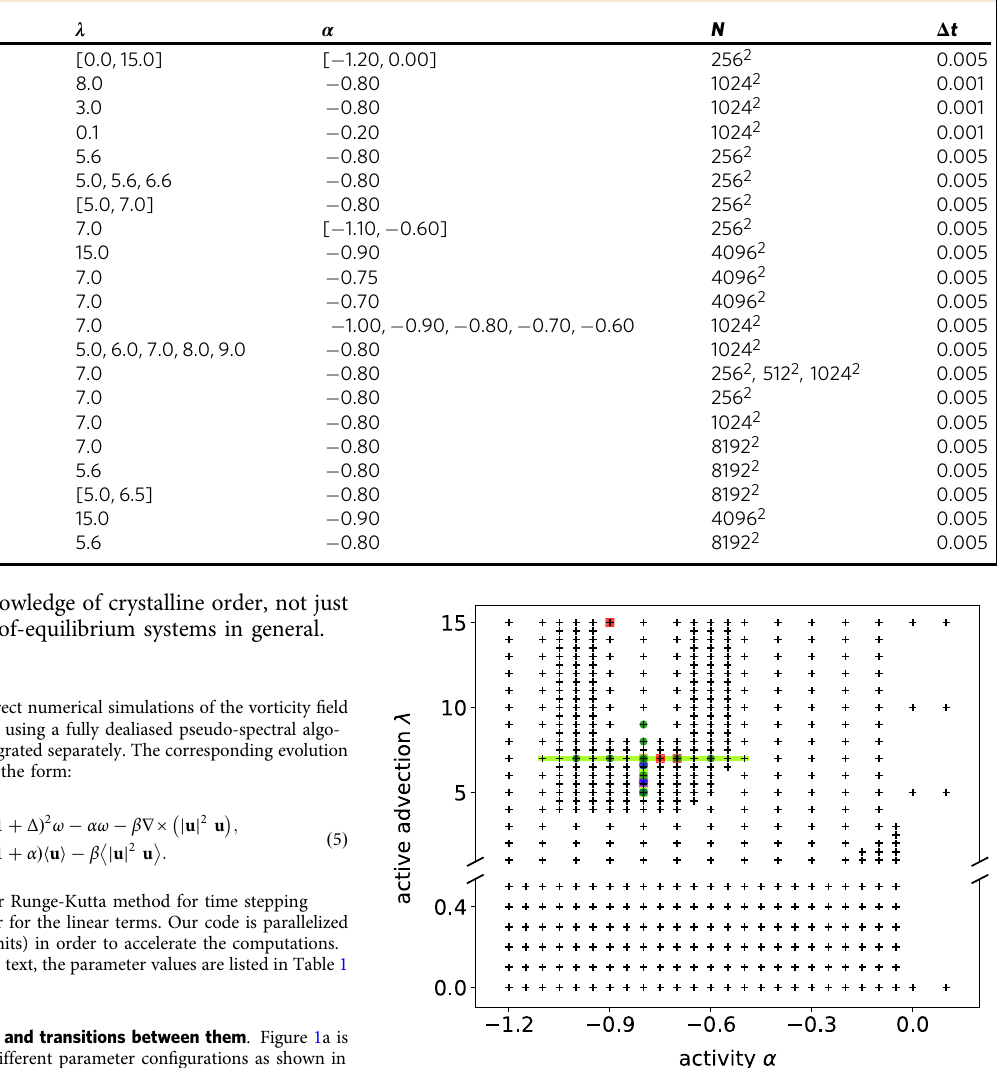
Table 1 Simulation parameters: Domain size L , active advection parameter λ , activity parameter α , number of grid points N , time step Δ t . The parameter β is set to 0.01 in all simulations. Values in parentheses represent parameter ranges of simulation series.